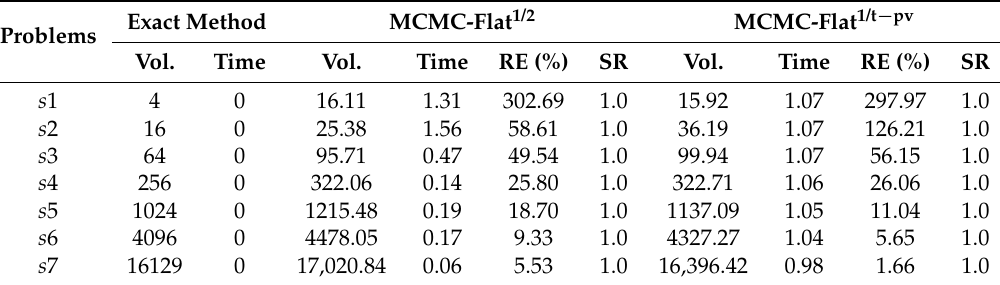
Table 2. Comparison of Exact Method and MCMC-Flat methods on structural